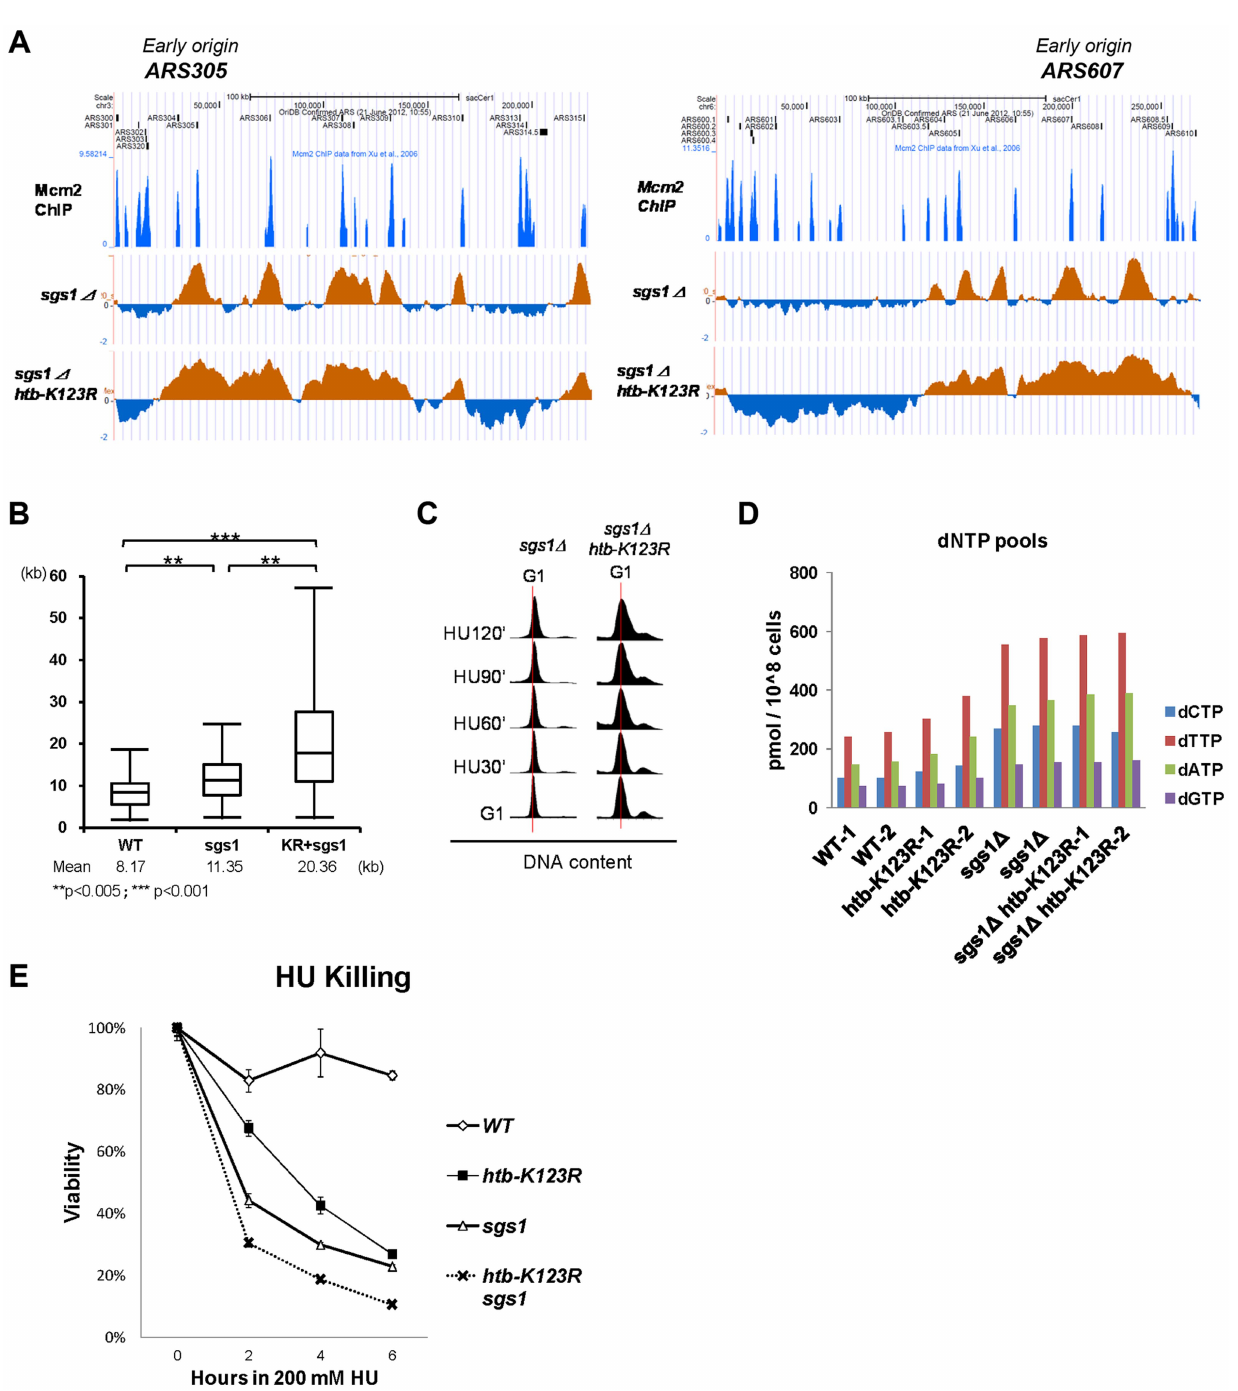
Figure 6. H2Bub and Sgs1 cooperatively control replication fork stalling and stability under HU. (A) Replication profiles of the early origins ARS305 and ARS607 in sgs1 D (YCL007) and sgs1 D htb-K123R (YCL008) mutants. The BrdU histogram was analyzed as described in Fig. 1C–E. (B) Graph depicting the distribution of BrdU track lengths in WT (CFK1419), sgs1 D (YCL007), and sgs1 D htb-K123R (YCL008) mutants, as shown in Fig. 1F. (C) Cell cycle progression of these mutants in the presence of 0.2M HU was analyzed by flow cytometry. (D) The size of the dNTP pools in exponentially-growing cultures of WT (CFK1419), htb-K123R (CFK1421), sgs1 D (YCL007), and sgs1 D htb-K123R (YCL008) cells in YPD media. Two independent isogenic strains of each genotype were analyzed. (E) Survival of WT (CFK1204), htb-K123R (CFK1231), sgs1 D (CFK1447), and sgs1 D htb- K123R (CFK1453) cells in response to acute doses of HU, as shown in Fig. 1A. hypothesis supported by the observation that the double mutant suggest that H2Bub is involved in stalling the replication fork was more sensitive to acute treatment with HU than either and maintaining its stability in response to HU-induced S phase single mutant (Fig. 6E). Taken together, our results so far block; furthermore, this function is performed in cooperation